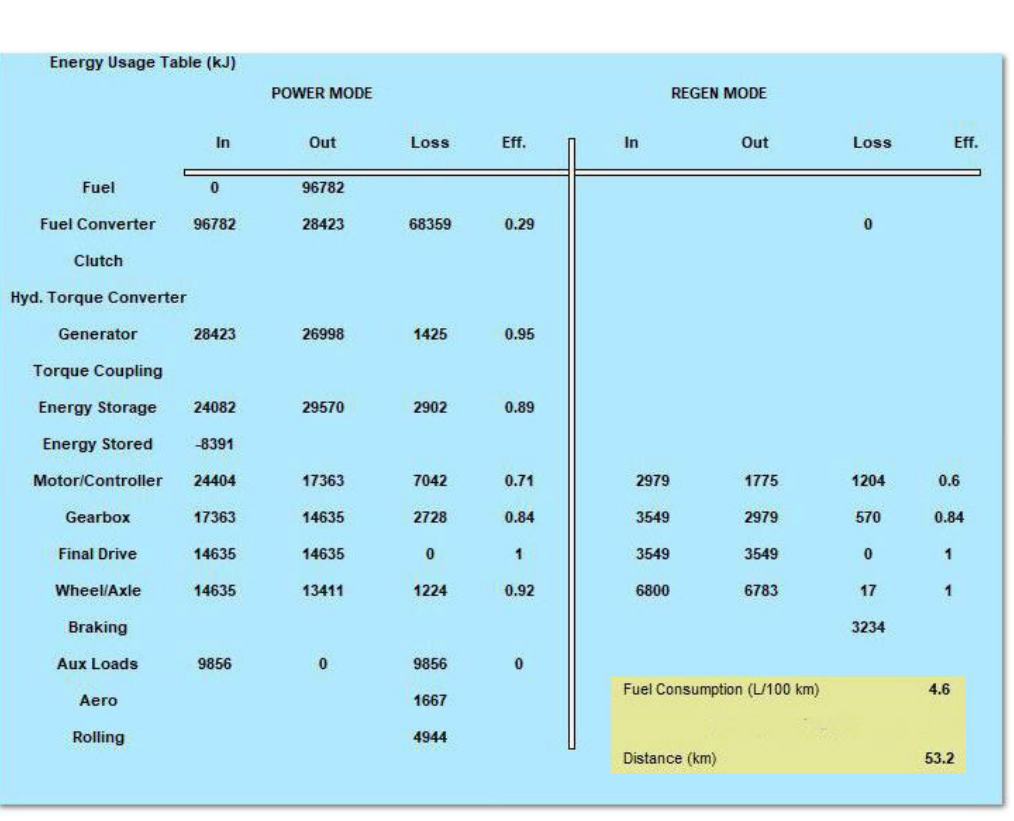
Table 17. WVUCITY cycle results.